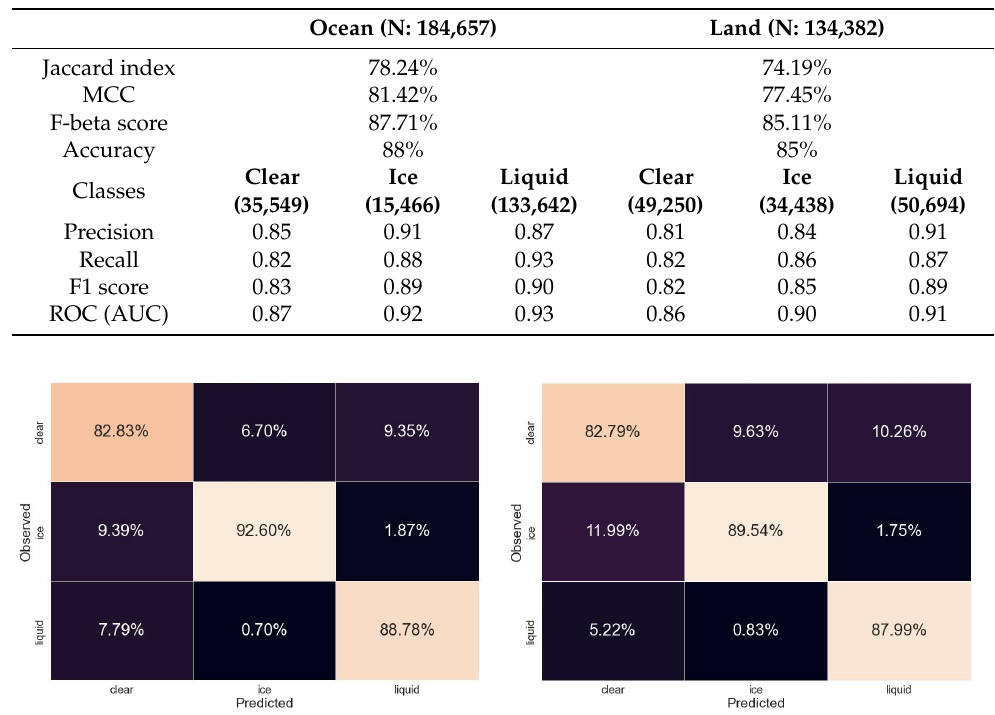
Table 4. As in Table 3 but using synthetic dataset for AMSU-A and MHS sensors.